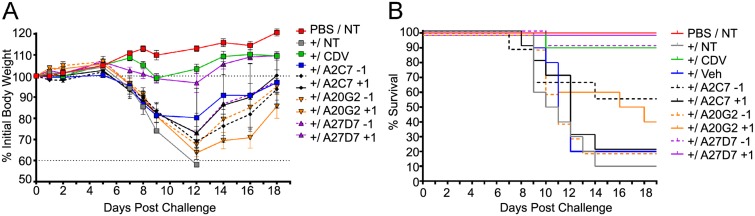
Treatment with antibody A27D7 protects mice against a lethal ECTV challenge.Mice were treated with A2C7, A20G2 or A27D7 at T = -1 or T = +1 relative to a 1000 PFU ECTV challenge. (A) Mice were monitored for morbidity, as measured by weight-change. Mice treated with A27D7 at T = +1 were fully protected against morbidity. N = 5 mice/group. Data presented is from 1 of 2 studies—both with similar results. (B) Mice were monitored for mortality until T = +21. Only mice treated with A27D7 were significantly protected against challenge. P = 0.0004 for T = +1 and P = 0.006 for T = -1 (90% protected). N = 10 animals/group. Data is pooled from 2 independent studies of 5 animals/group. Controls include no ECTV challenge (PBS/NT), challenge without treatment (NT), treatment with vehicle only (Veh) or CDV treatment.